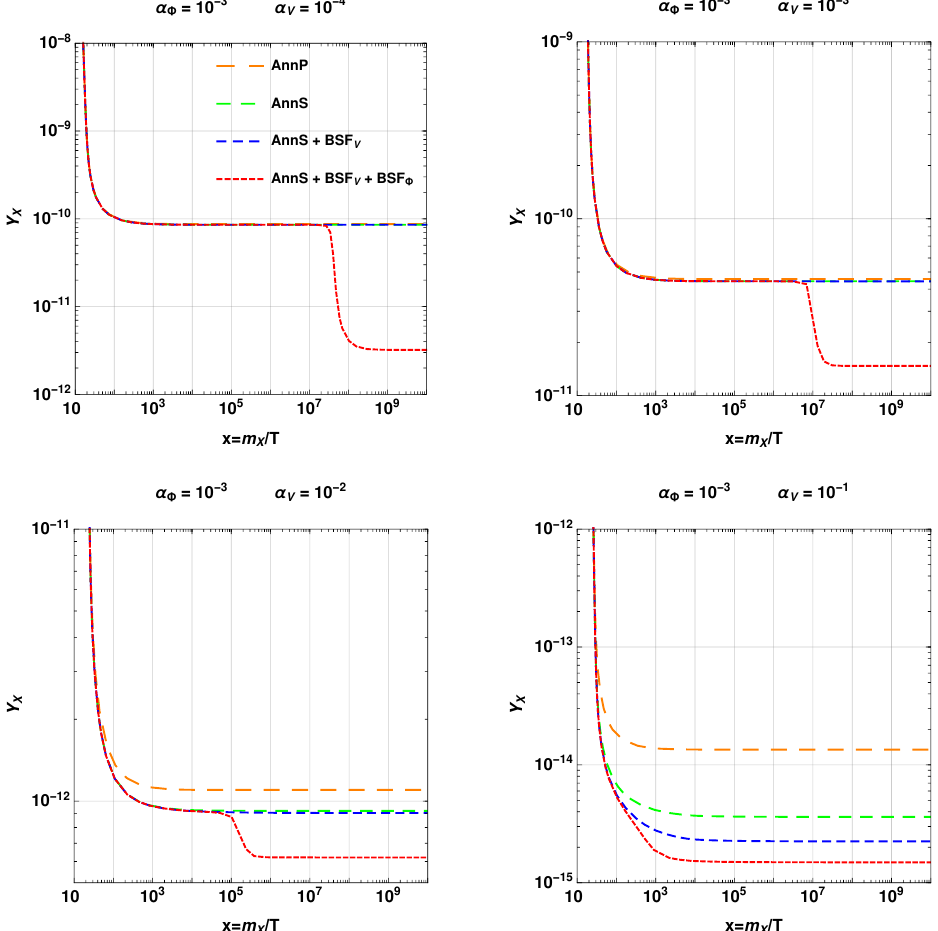
Figure 16 . The evolution of the DM yield Y section 3.2. We have (cid:12)xed m